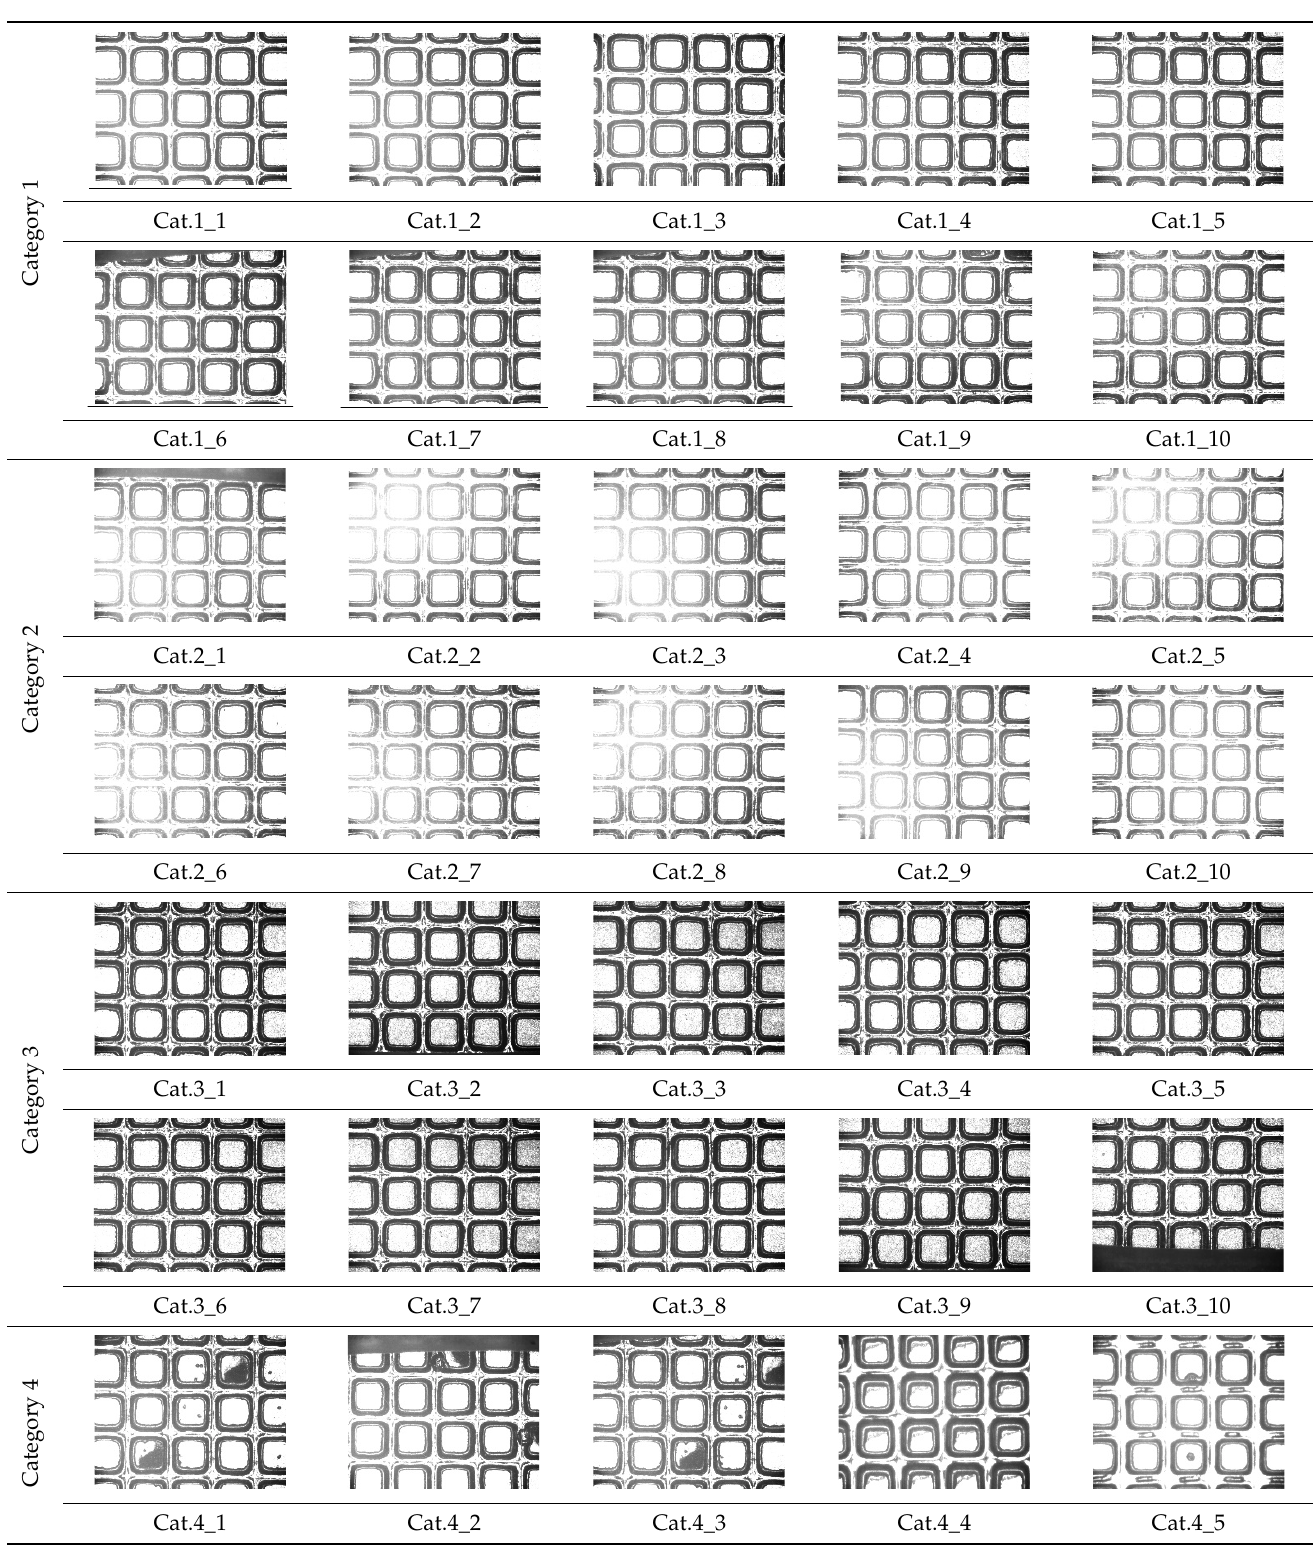
Table 1. Part of the wafer images.